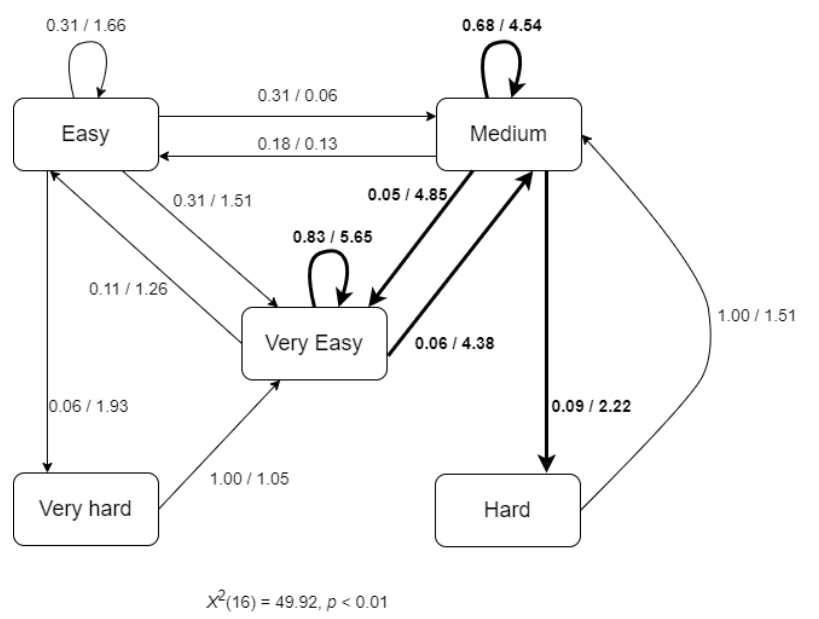
Figure 4. The sequential problem-solving behavior of hare hunters in terms of difficulty of problem solved shows that hare hunters solved diverse types of arithmetic problems.